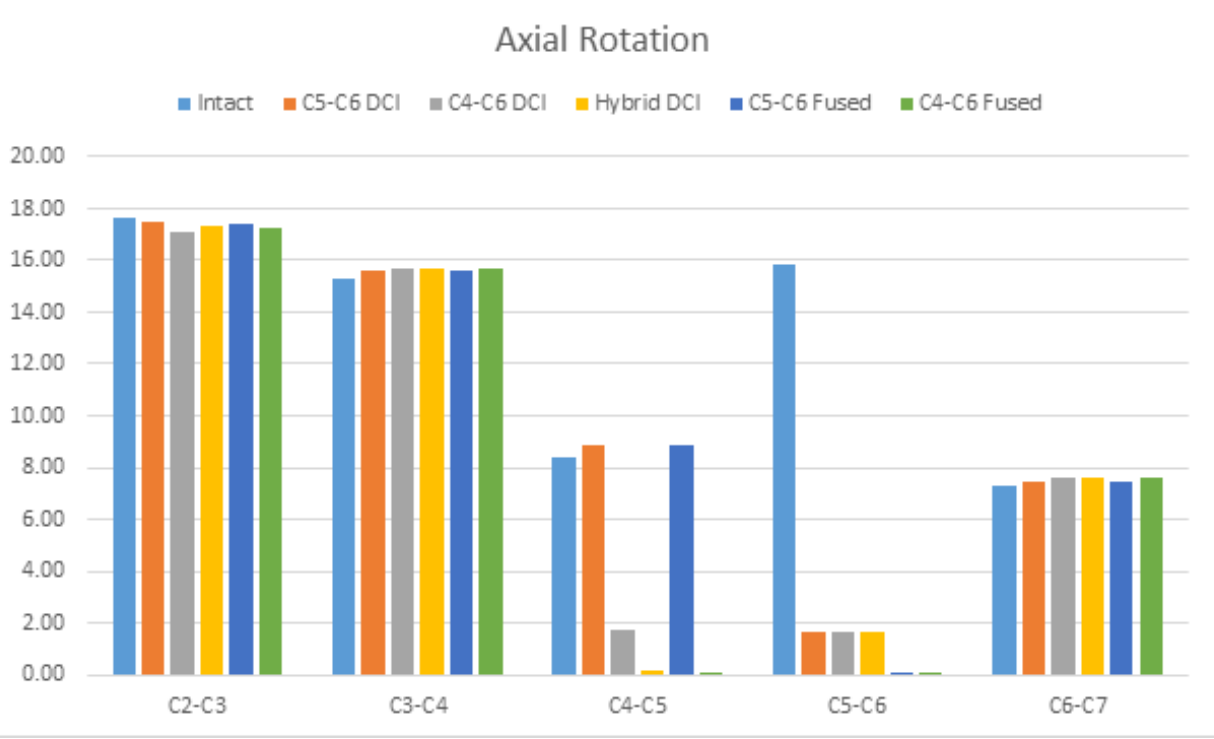
Figure 7. The comparison of ROMs during axial rotation among the C5–C6 DCI, C4–C6 DCI, hybrid DCI, C5–C6 ‐ fused, and C4–C6 ‐ fused models. The vertical axis shows ROMs in degrees.